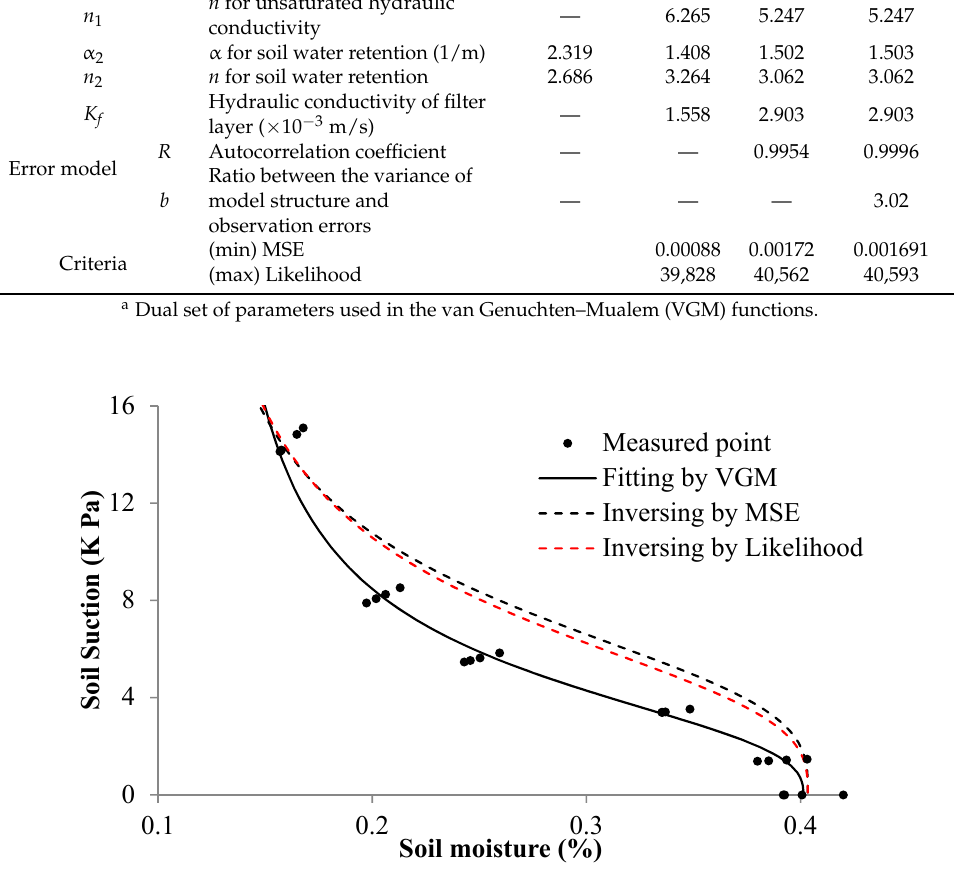
Table 3. Description of model parameters with measured values and optimized results.